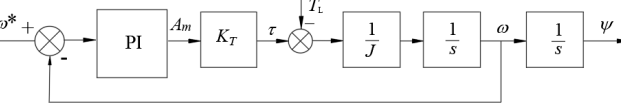
Figure 11. The position controller transfer function model.